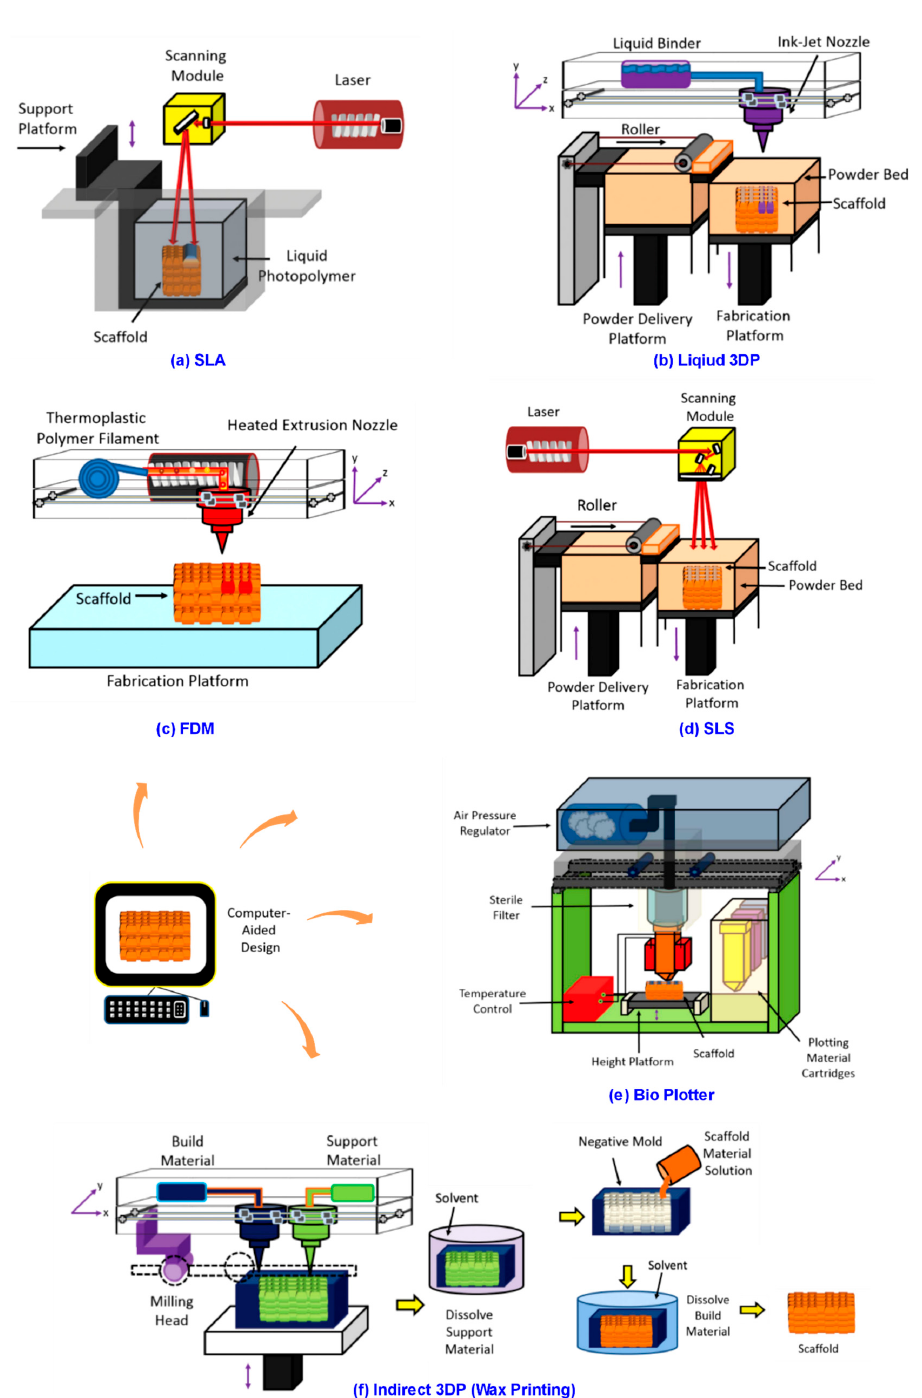
Figure 1. Graphic illustration of six typical three-dimensional printing (3DP) technologies for 3D scaffold fabrication, adapted, and re-structured based on previous work [41] and [53].